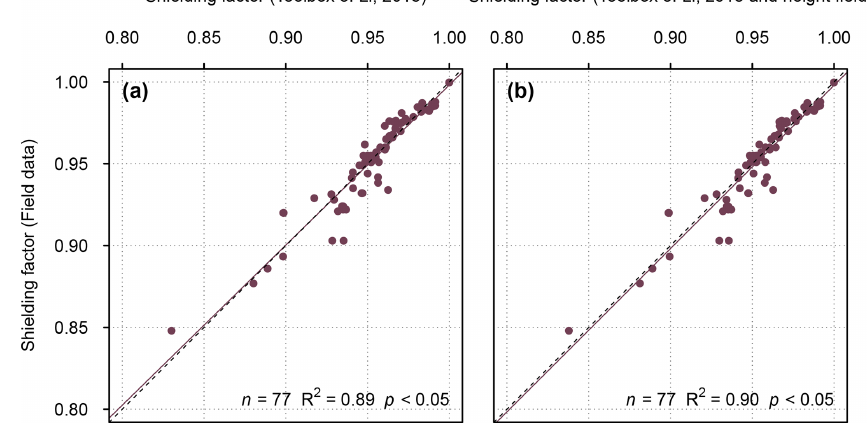
Figure 2. (a) Shielding factors for moraine boulders in the southern Black Forest, the Écrins massif and in the forefield of Steingletscher de- termined with SRTM elevation data versus field-data-based shielding factors. Panel (b) is the same as panel (a) , but the shielding factors were corrected for the boulder height. For field-data-based shielding factors for boulders in the Écrins massif and in the forefield of Steingletscher, see Le Roy et al. (2017) and Schimmelpfennig et al. (2014),